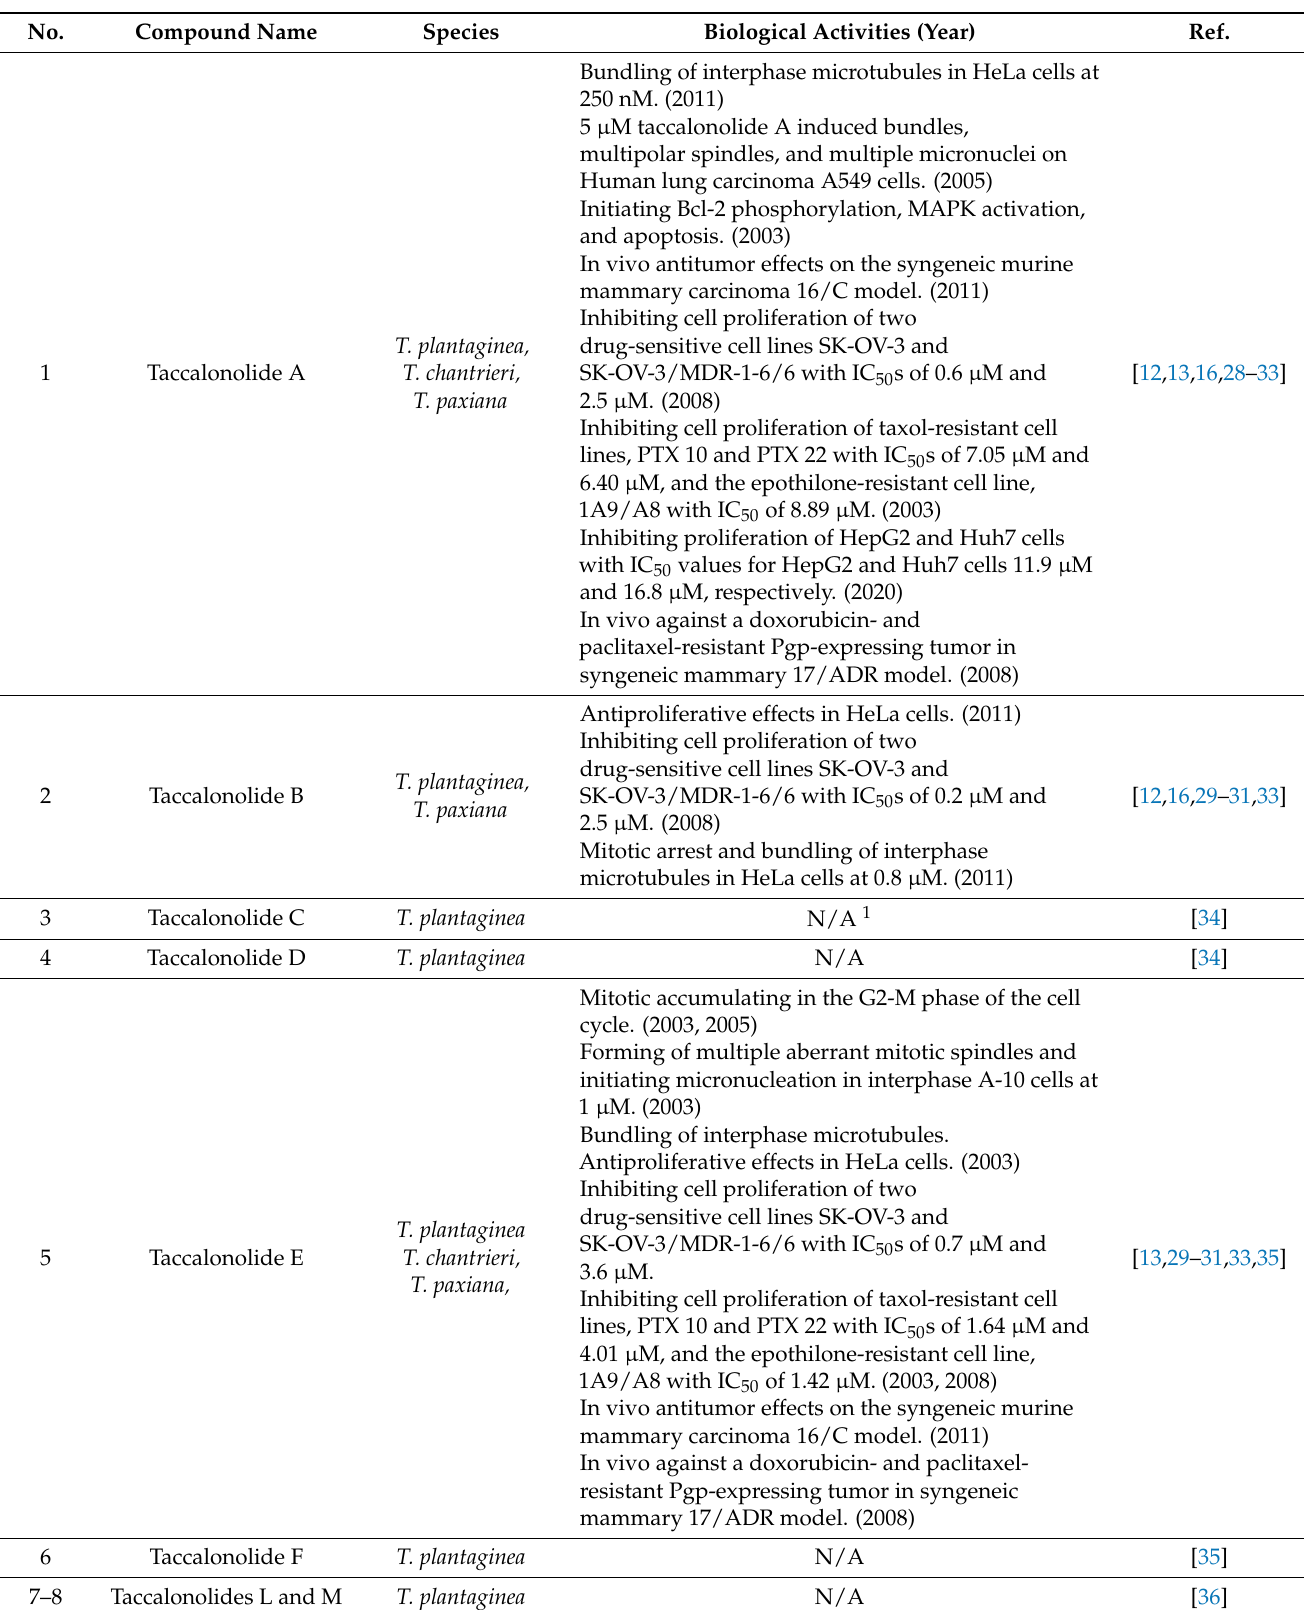
Table 1. Natural taccalonolides listed chronologically based on their first appearance in publications.